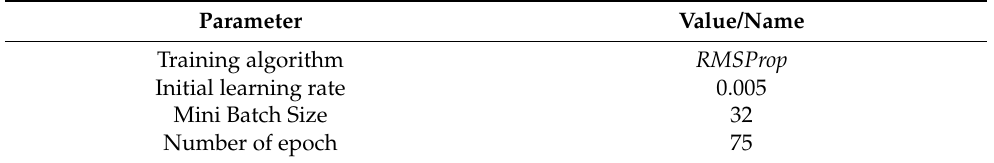
Table 4. Training algorithm and its parameters [26].